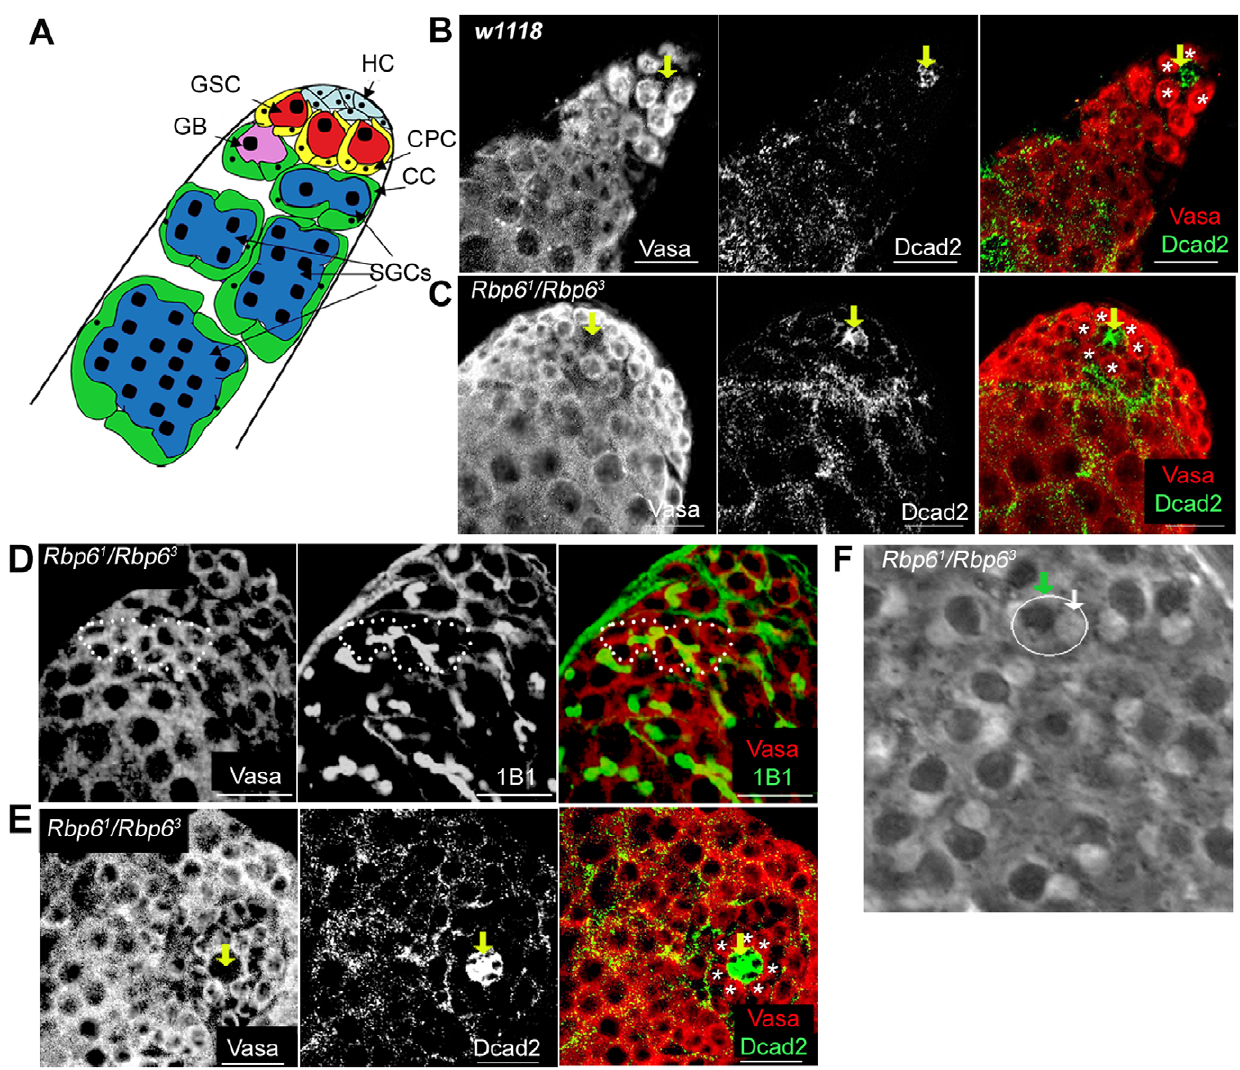
Figure 6. Rbp6 is not required for spermatogenesis. (A) Cartoon representation of the apical region of the Drosophila testis. GSCs (red) are located next to a group of somatic hub cells (HC, pale blue). Each GSC is surrounded by a somatic stem cell called a cyst progenitor cell (CPC, yellow). The GSC daughter, called the gonialblast (GB, pink), undergoes four rounds of mitosis to generate a cyst of 16 interconnected spermatogonial germ cells (SGCs, dark blue) (adapted from [10]). (B) Confocal image of a w 1118 adult testis stained with a germ cell marker (Vasa, red) and a marker that accumulates on somatic cell membranes (Dcad2, green). GSCs are labelled (*) in the merged image, hub is labelled with an arrow. (C) Rbp6 1 /Rbp6 3 mutant testis have normal numbers of Vasa-labelled GSCs (*) surrounding the hub (arrow). (D). A cyst of 8 interconnected germ cells (Vasa, red, white dotted line) connected by the spectrin-rich fusome (1B1 (adducin-related), green) in a Rbp6 1 /Rbp6 3 mutant testis. Cysts appear to be generated normally in Rbp6 mutant testes. (E) A Rbp6 1 /Rbp6 3 mutant testis with a displaced hub (Dcad2, green) have normal numbers of GSCs (*) abutting the hub (arrow). (F) A phase contrast micrograph of onion-stage spermatids in a Rbp6 1 /Rbp6 3 testis shows one haploid nucleus (white arrow) and one mitochondrial derivative (green arrow), each approximately the same diameter. Scale bars: 20 m